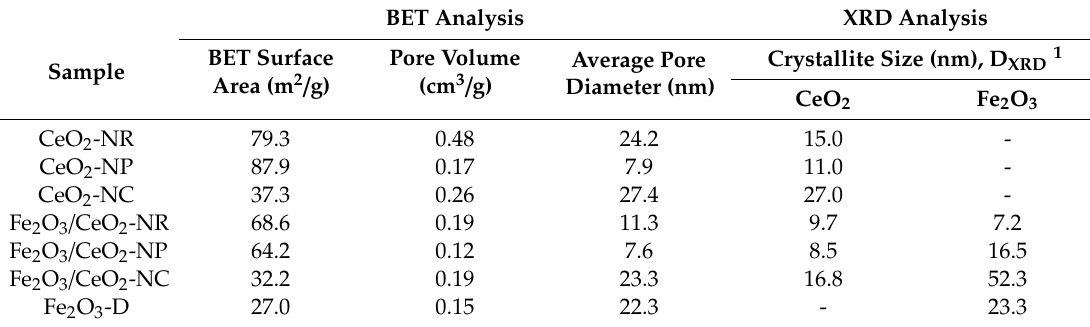
Table 1. Textural / structural characteristics of bare CeO 2 , Fe 2 O 3 -D, and Fe 2 O 3 / CeO 2 samples. Table 1. Textural/structural characteristics of bare CeO 2 , Fe 2 O 3 ‐ D, and Fe 2 O 3 /CeO 2